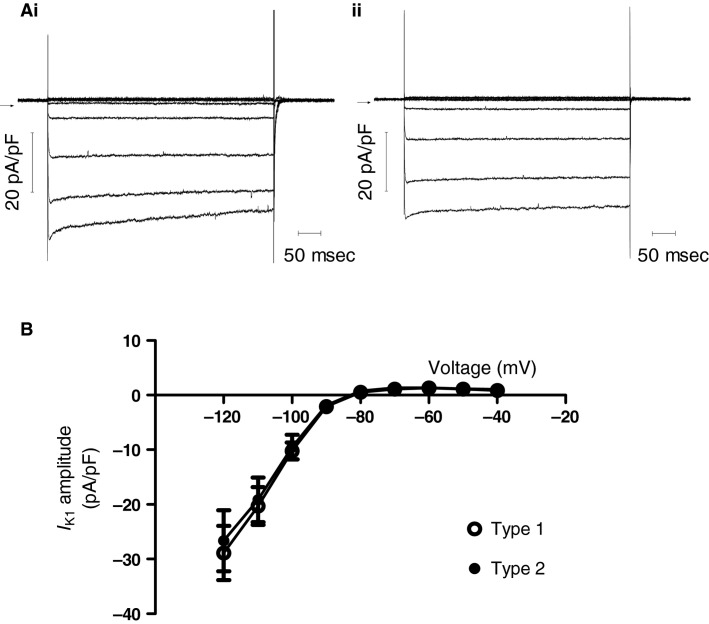
Inward rectifier K+ current. Horizontal arrow denotes zero current level. (B) I–V relation for Ba2+-sensitive IK1 (measured at start of voltage command) in Type 1 (open circle; n = 7) and Type 2 (filled circle, n = 6) cells.